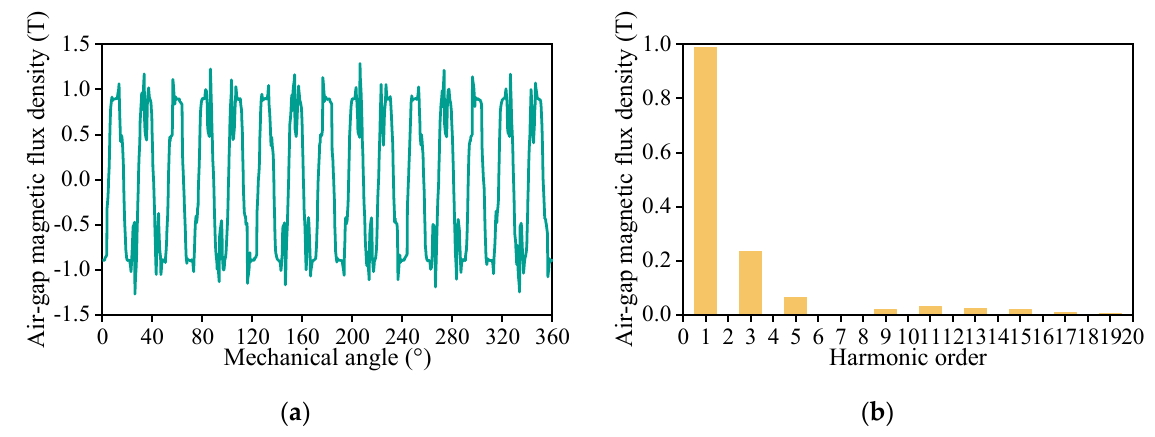
Figure 2. Magnetic flux density distributions under no-load state and rated load: ( a ) no-load state; ( b ) rated load.